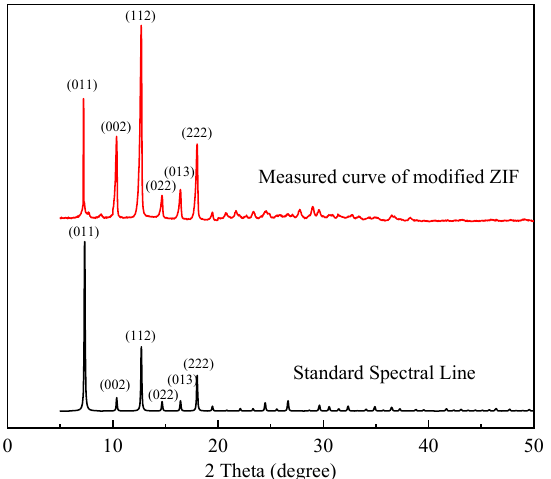
Figure 5. XRD patterns of modified ZIF before and after aging at 200 °C for 32 h.